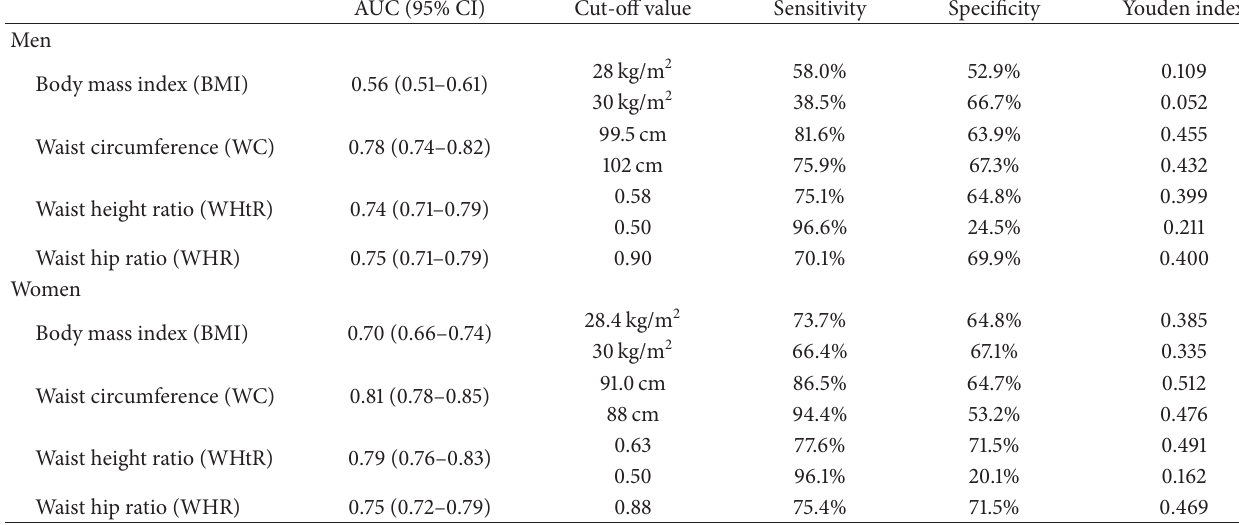
Table 3: Area under the ROC curve, optimal cut-off points, and validity parameters of different obesity indices in predicting MetS ( 𝑁 = 1 , 552